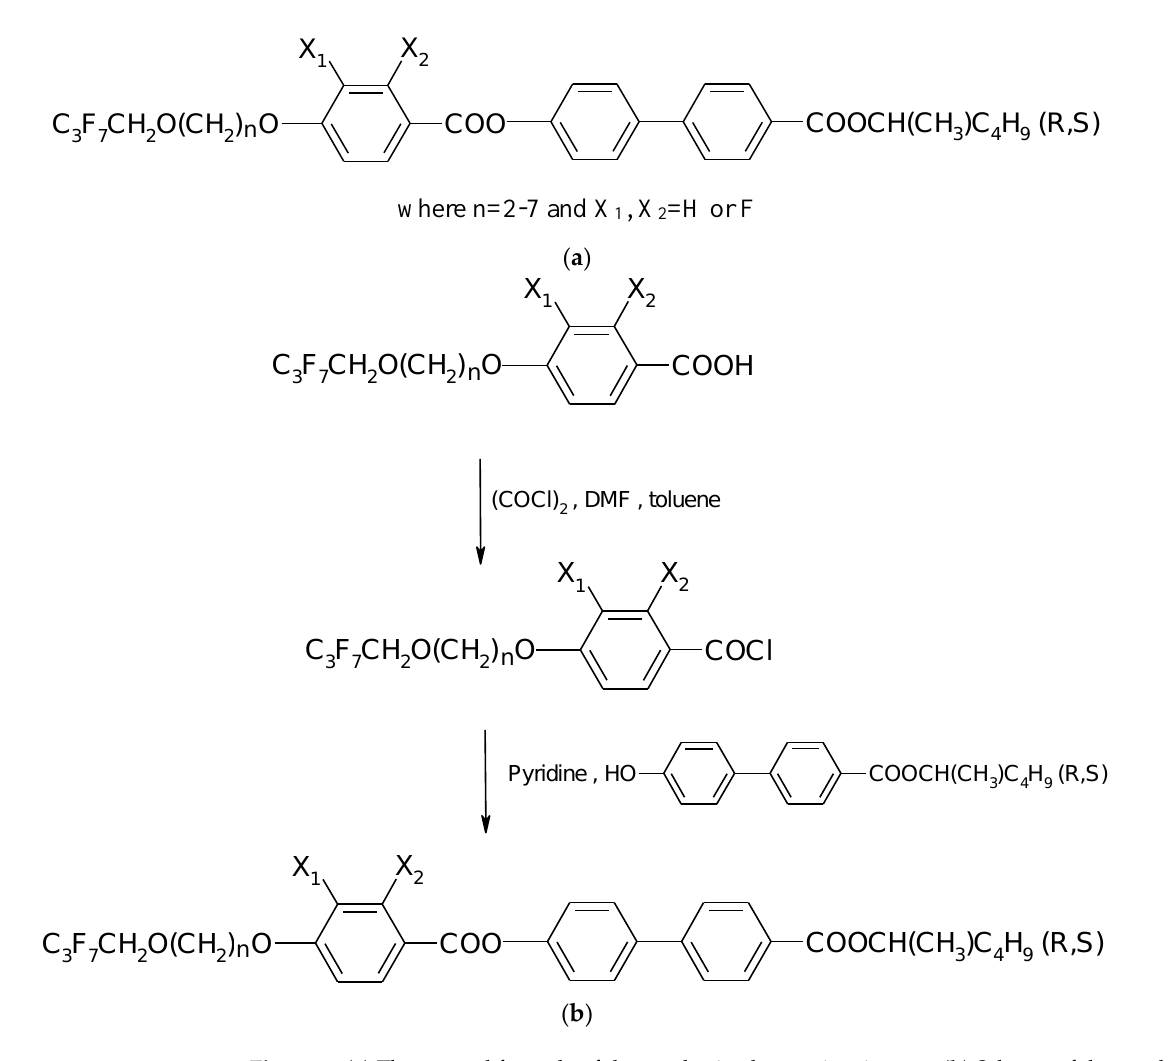
Figure 2. ( a ) The general formula of the synthesized racemic mixtures. ( b ) Scheme of the synthesis of the new racemic mixtures.